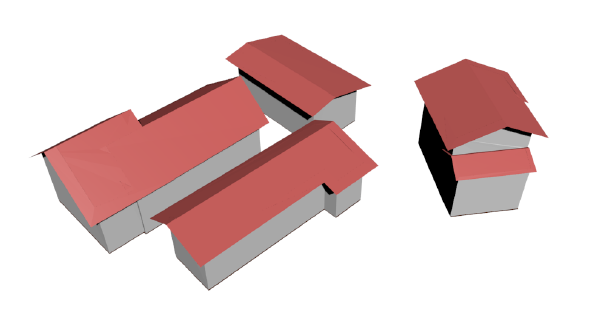
Figure 11: Wrong aggregation of Buildings into one Abstract- Building.